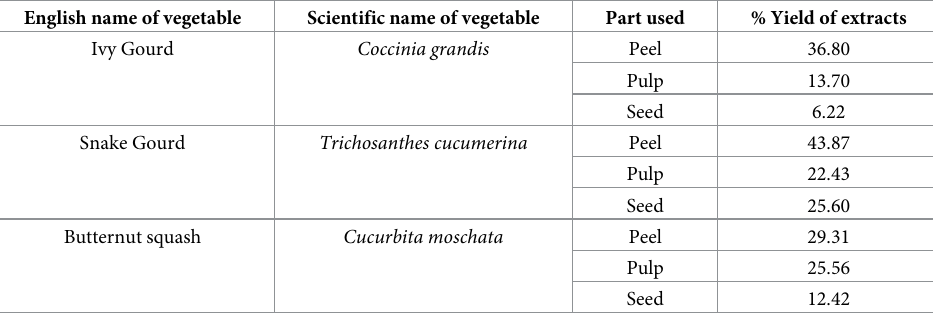
Table 1. The percentage yield of extracts from the peel, pulp, and seeds of studied Cucurbitaceae vegetables. English name of